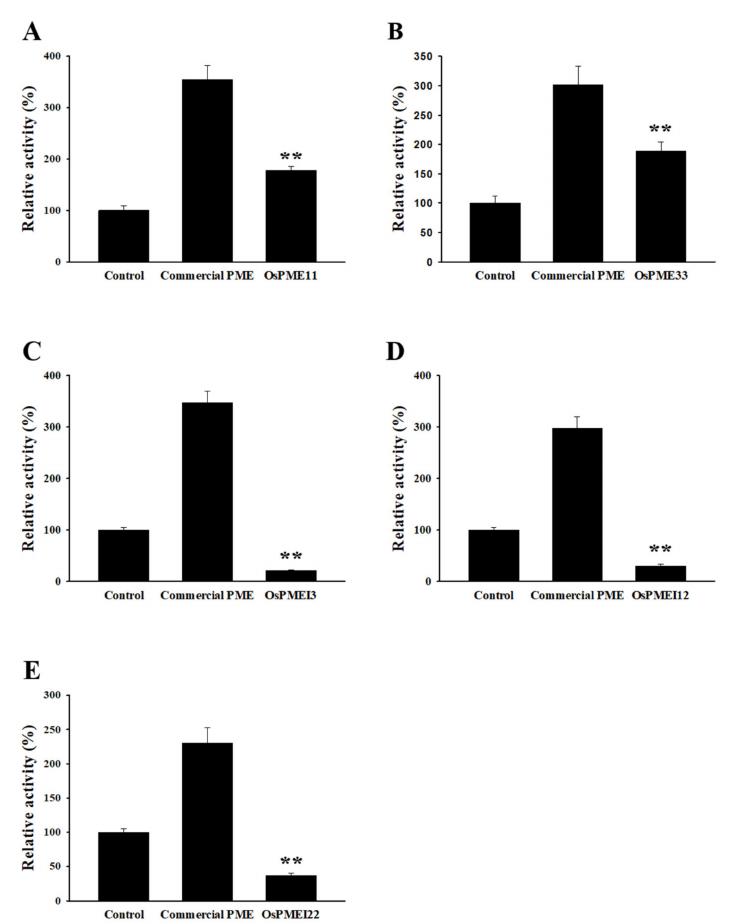
Figure 6. Enzyme activity assay of rice pollen-specific PMEs and PMEIs. Commercial PME (Sigma Aldrich, Cat No. P5400) was included in all reactions as a positive control. The empty vector was used as a control. The activity of commercial PME and PME / PMEI was expressed as a percentage of that of the control (empty vector). ( A ) PME11. ( B ) PME33. ( C ) PMEI3. ( D ) PMEI12. ( E ) PMEI22. Error bars represent the SE of three biological replicates. ** p -value < 0.01, based on t